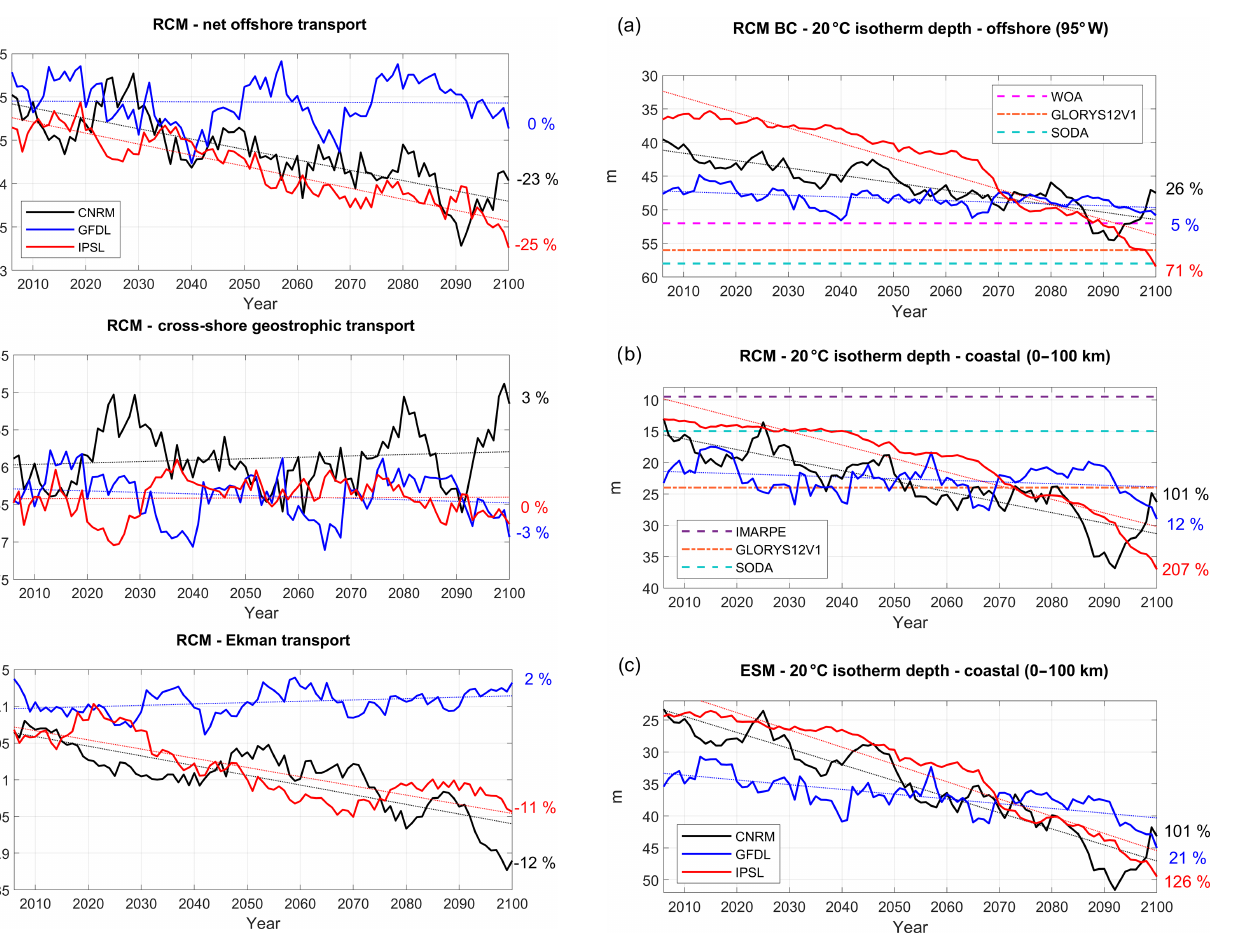
Figure 6. Depth of 20 ◦ C isotherm (D20, in meters) (a) at 95 ◦ W, averaged between 2 ◦ N and 10 ◦ S (see red vertical line in Fig. 2b), (b) in the coastal box for the three RCMs and (c) for the three ESMs (CNRM in black, GFDL in blue, IPSL in red). The time series are filtered using a 10-year moving average. Climatological D20 from WOA (dashed magenta line) and two reanalyses (dashed–dotted orange line for GLORYS12V1 (1993–2017), dashed cyan line for SODA (1992–2000)) are also shown in (a) . D20 from IMARPE cli- matology is marked by a dashed purple line in (b) . Annual mean time series are filtered using a 10-year moving